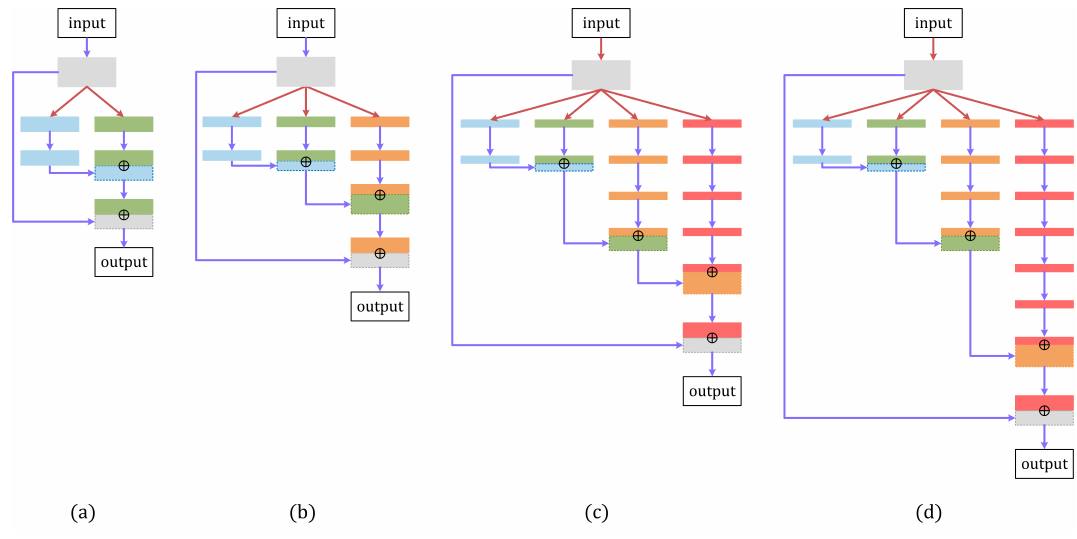
Figure 2. SC blocks with different configurations. ( a ) SC-(2,1,2); ( b ) SC-(3,2,2,4); ( c ) SC-(4,2,2,4,6); ( d )